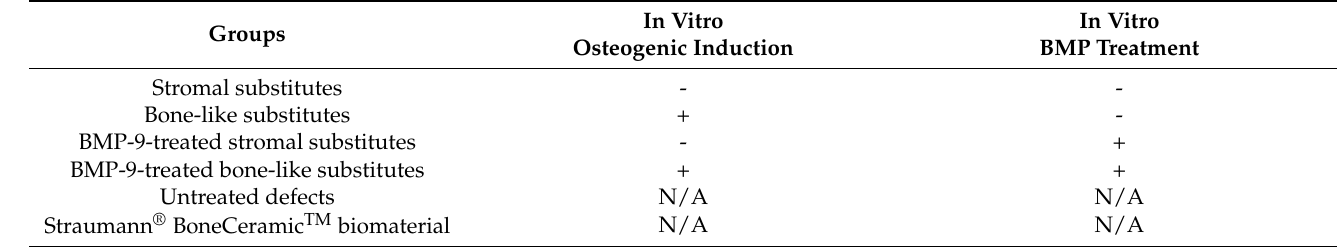
Table 2. List of the experimental groups for in vitro assays and in vivo implantation studies.